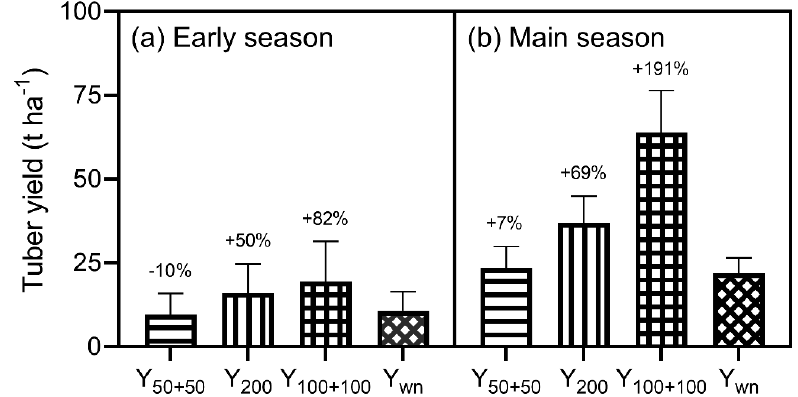
Figure 6. E ff ect of di ff erent nitrogen fertilization strategies on the early ( a ) and main ( b ) season potato yields (Y 50 + 50 , current rate with basal-top dressing ratio of 1:1; Y 200 , doubled rate with all basal dressing; Y 100 + 100 , doubled rate with basal-top dressing ratio of 1:1; Y wn , current rate with all basal dressing). Values above error bars indicate the e ff ects of nitrogen fertilizer applications. Error bars indicate standard deviation over the